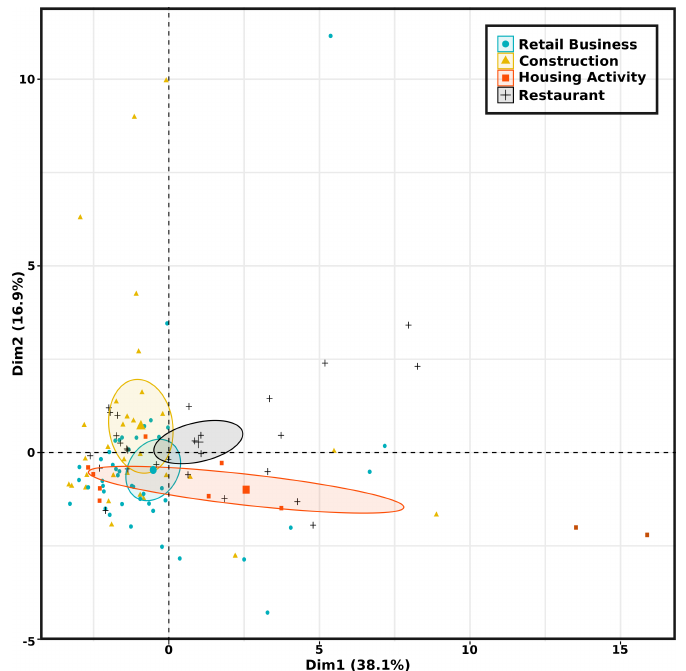
Figure 17. Dispersion plot in the PCA’s coordinate system